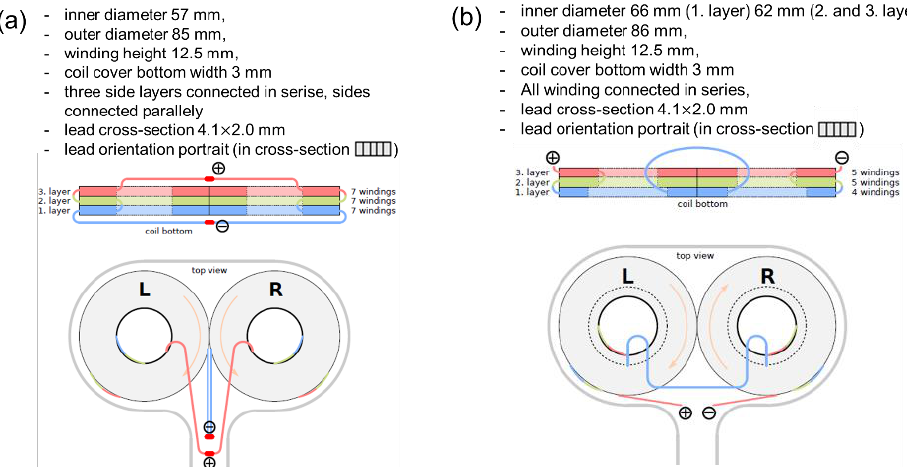
Figure 1. Structure of active and sham coils and their parameters. ( a ) represents an active coil (DuoMAG 70BF) and ( b ) shows a special sham coil (DuoMAG 70BFP). The top row is a cross-sectional view of the coil from the side, while the bottom row is a plain view from the top. The red, green, and blue colored areas and lines in the cross-sectional view indicate the coil windings and their layers. The doughnut-shaped white area inside of the coil indicates the inner empty core of the coil winding. The plus and minus in the figure represent the direction of the current flow in the coil along with the orange arrows drawn inside the left and right coils on the top view.